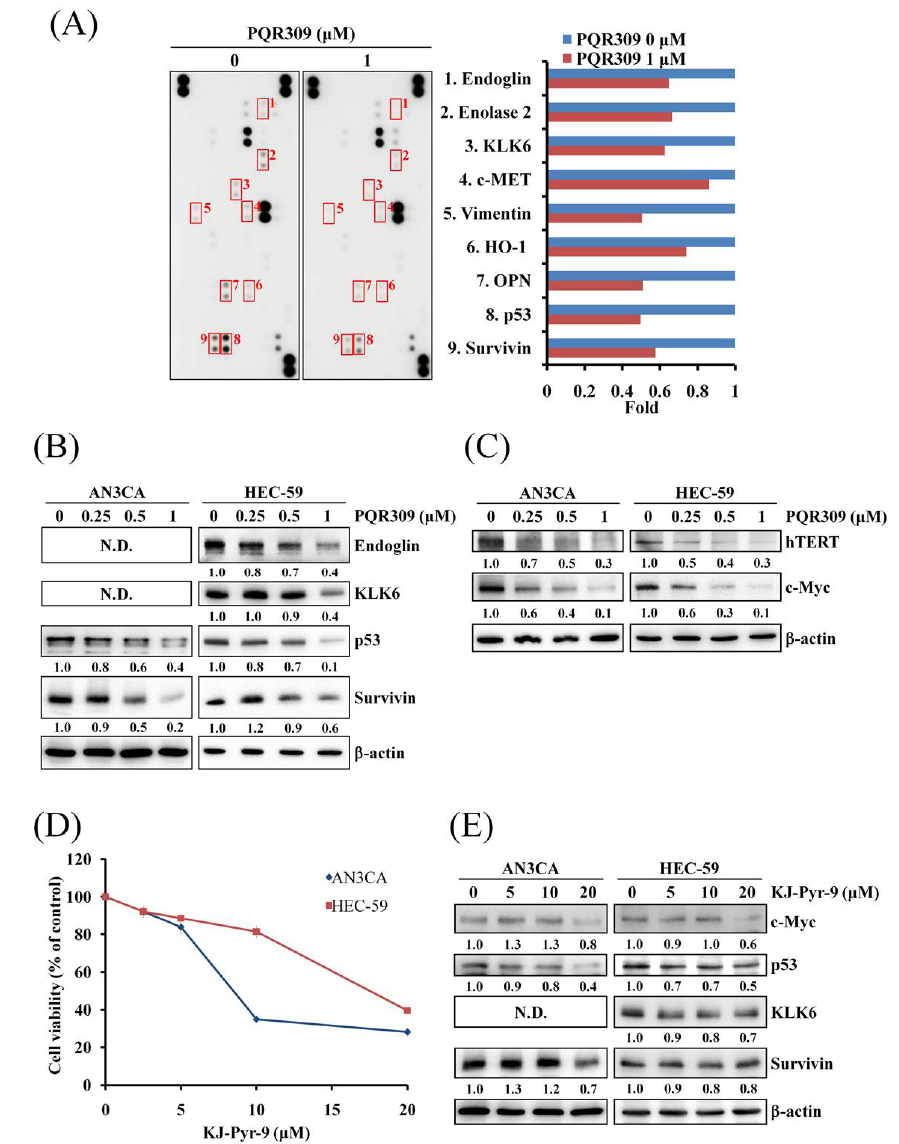
Figure 5. Effect of PQR309 on the expression of c-Myc and its possible target genes. ( A ) After treating with PQR309 for 48 h in HEC-59 cells, Proteome Profiler Human XL Oncology Array was performed according to the manufacturer protocol. The dot intensities were quantified by ImageJ software. The ratio of cells without treatment was set at 1. ( B ) After treating with PQR309 in AN3CA and HEC-59 cells for 48 h, protein expressions of endoglin, KLK6, p53, and survivin were determined by Western blot. ImageJ software was used to quantify the band intensities of endoglin, KLK6, p53, and survivin. Data shown are the relative expression standardized by the β-actin protein level. The ratio of cells without treatment was set at 1. ( C ) Western blot assay was performed to detect the expressions of hTERT and c-Myc in AN3CA and HEC-59 cells after PQR309 treatment for 48 h. ImageJ software was used to quantify the band intensities of hTERT and c-Myc. Data shown are the relative expression standardized by the β-actin protein level. The ratio of cells without treatment was set at 1. ( D ) AN3CA (5 × 10 3 cells/well of 96-well plate) and HEC-59 (6 × 10 3 cells/well of 96-well plate) were treated with KJ-Pyr-9 (0, 2.5, 5, 10 and 20 μM), an inhibitor of c-Myc, for 72 h. Cell viability was analyzed by MTT assay. ( E ) Protein expressions of c-Myc, p53, KLK6, and survivin were determined by Western blot. ImageJ software was used to quantify the band intensities of c-Myc, p53, KLK6, and survivin. Data shown are the relative expression standardized by the β-actin protein level. The ratio of cells without treatment was set at 1. N.D., not detected.